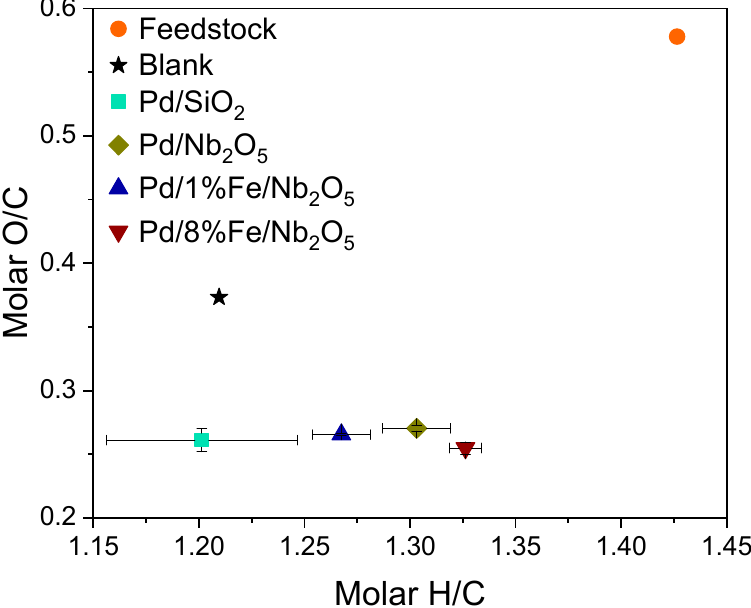
Figure 7. Van Krevelen diagram of feedstock and upgraded oils on different catalysts and in the absence of a catalyst (blank).